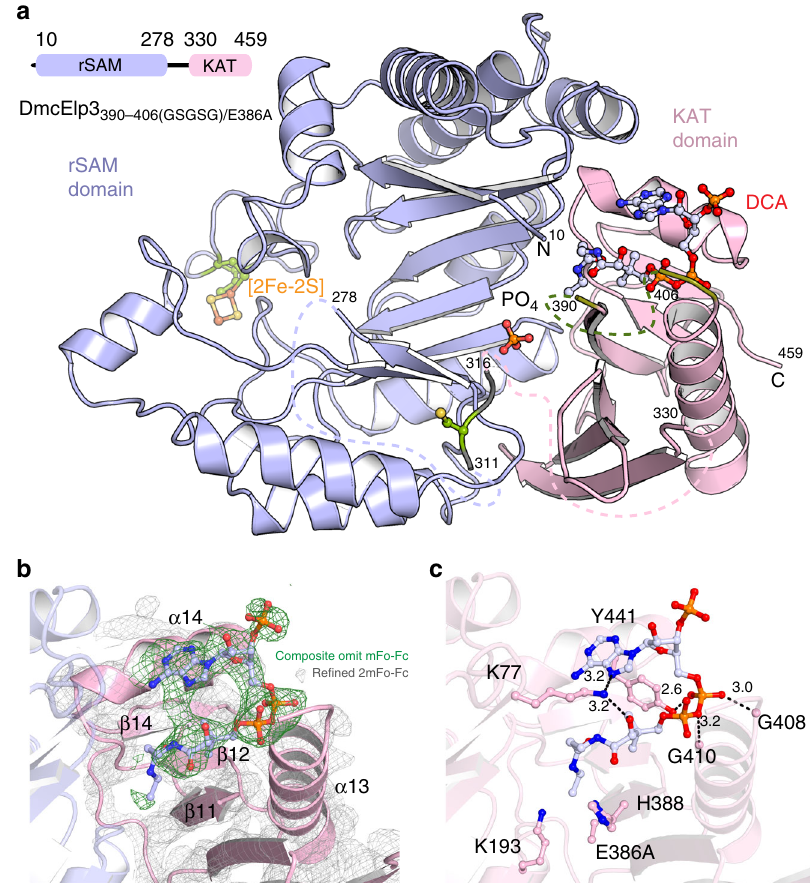
Fig. 1 The crystal structure of DCA bound to DmcElp3 390 – 406(GSGSG)/E386A . a Overall structure of DmcElp3-DCA in cartoon representation. The rSAM domain (blue), KAT domain (pink), and acetyl-CoA blocking loop (olive) are highlighted. Disordered loops are shown using dotted lines. Fe – S cluster binding and zinc binding residues are highlighted in green. Fe – S cluster (orange and yellow spheres) and PO 4 (orange and red spheres) are highlighted. Respective amino acid numbers are indicated. b The Fo – Fc simulated annealing omit map (green) of DCA and the re fi ned 2Fo – Fc map (gray) are shown at 1.5 σ in the binding pocket of DmcElp3 390 – 406(GSGSG)/E386A . The model of DmcElp3 is shown in cartoon and the located DCA molecule in ball and sticks representations. c The interaction of DCA and the residues residing in the binding pocket of DmcElp3 390 – 406(GSGSG)/E386A . Hydrogen bonds are highlighted in dotted lines while bond lengths were analyzed using LigPlot. All involved residues and distance are